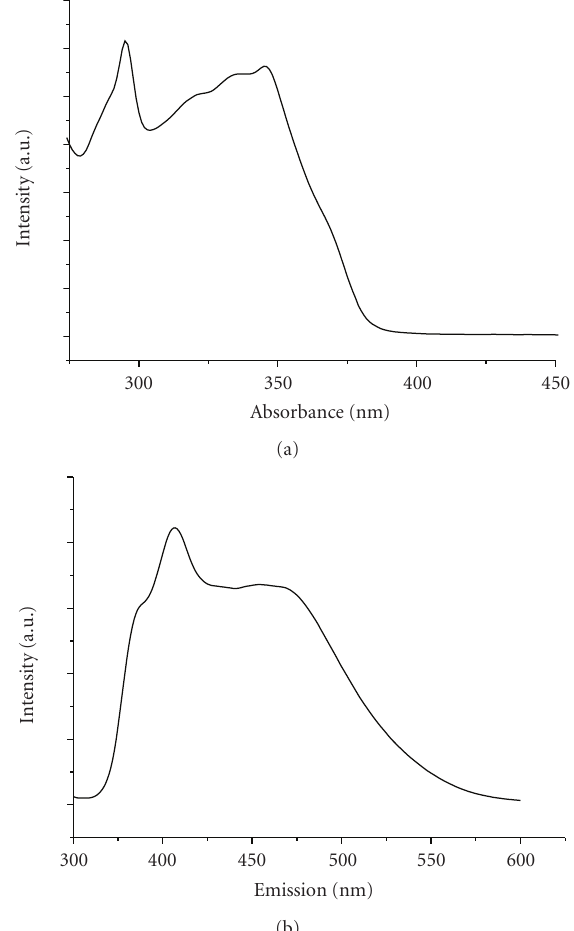
Figure 5: (a) Absorption and (b) photoluminescence of POC(12,6), irradiated at 345nm, in chloroform